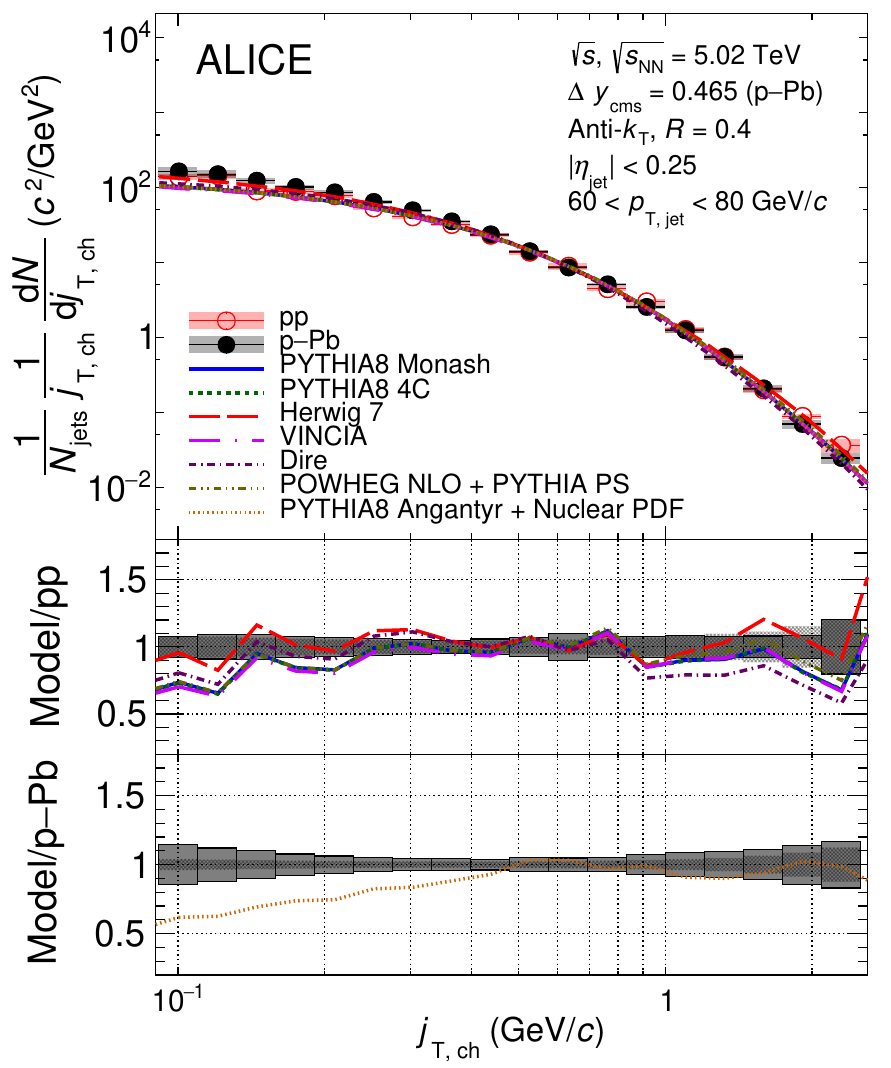
√ s NN = 5 . 02 TeV for jets with transverse √ s = 5 . 02